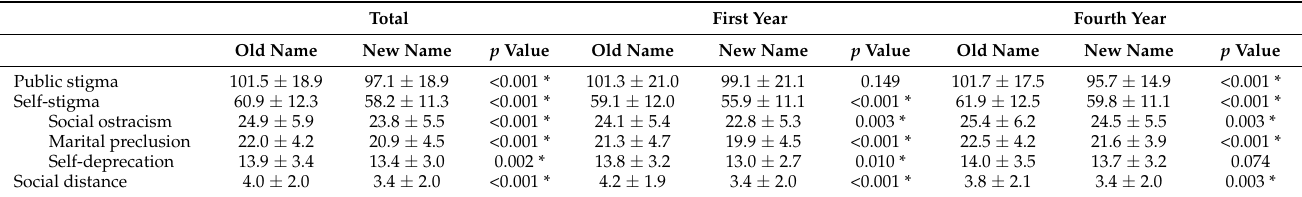
Table 2. The effects of renaming schizophrenia on